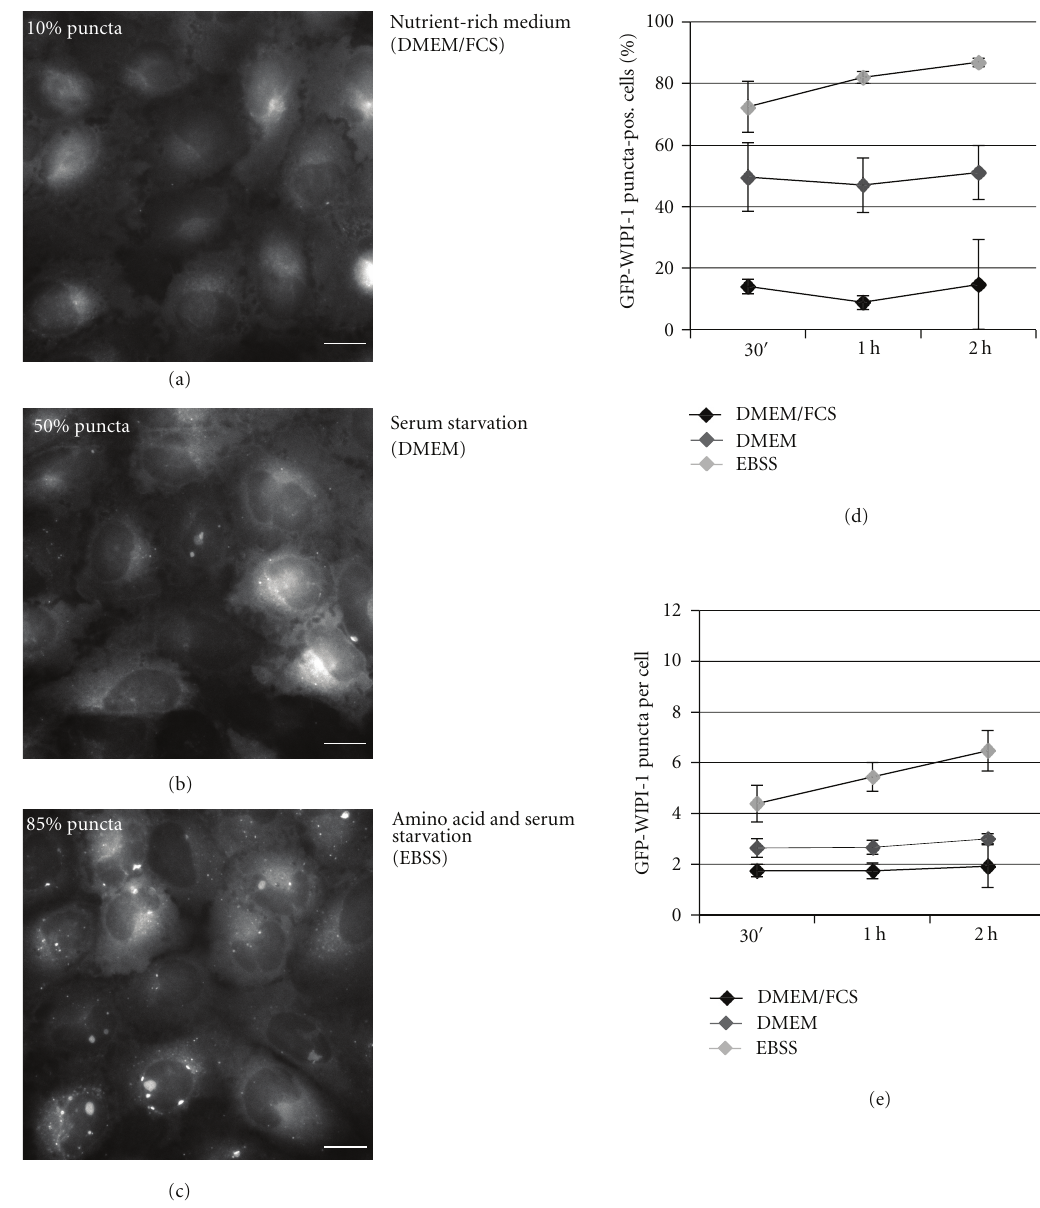
Figure 1: GFP-WIPI-1 puncta formation upon serum and amino acid starvation. GFP-WIPI-1 U2OS cells were treated with nutrient-rich culture medium (DMEM/FCS), serum-free culture medium (DMEM), or with medium lacking both serum and amino acids (EBSS) for 0.5, 1, and 2h. Fluorescence images were automatically acquired and 2h treatment images are shown ((a)–(c)). The number of GFP-WIPI-1 puncta-positive cells (d), and of GFP-WIPI-1 puncta per cell (e) was automatically determined. Each measure point represents mean value from up to 3000 individually analyzed cells per treatment condition ± SD ( n = 2, each in triplicates). Scale bars: 20 μ